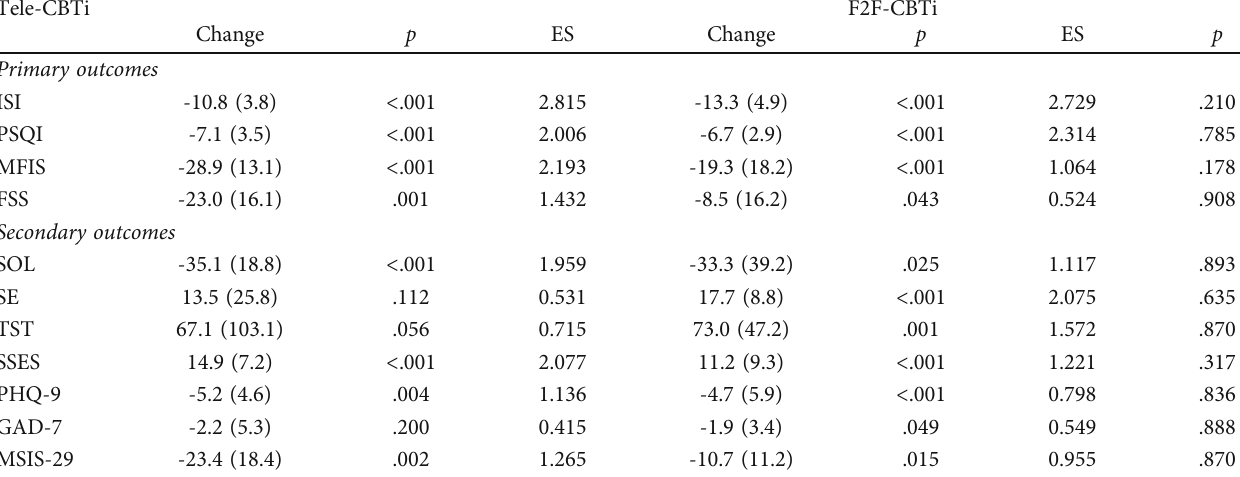
Table 3: Primary and secondary outcomes at baseline (pre), reassessment (post), change score, and e ff ect size. Data reported as mean (standard deviation). ISI: Insomnia Severity Index; PSQI: Pittsburgh Sleep Quality Index; MFIS: Modi fi ed Fatigue Impact Scale; FSS: Fatigue Severity Scale; SSES: Sleep Self-E ffi cacy Scale; SOL: sleep onset latency; SE: sleep e ffi ciency; TST: total sleep time; PHQ-9: Patient Health Questionnaire, 9 items; GAD-7: Generalized Anxiety Disorder Assessment, 7 items; MSIS-29: Multiple Sclerosis Impact Scale, 29 items; ES: e ff ect